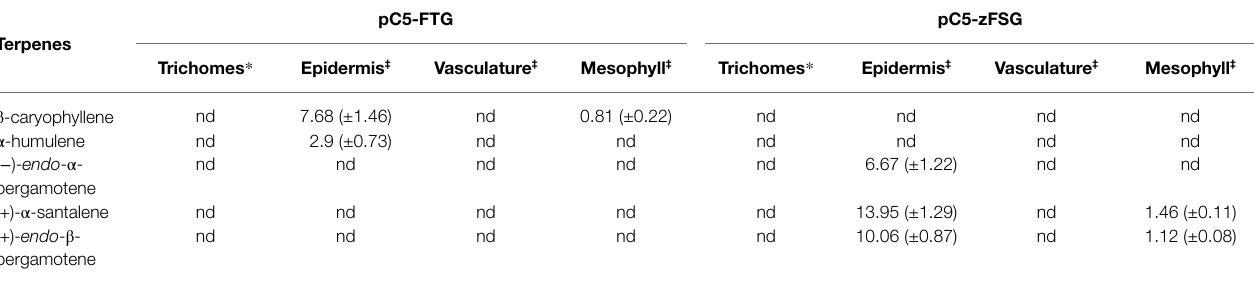
TABLE 1 | Accumulation of sesquiterpenes in different tissues of tomato leaves transiently transformed with the pC5-FTG and pC5-zFSG expression constructs.